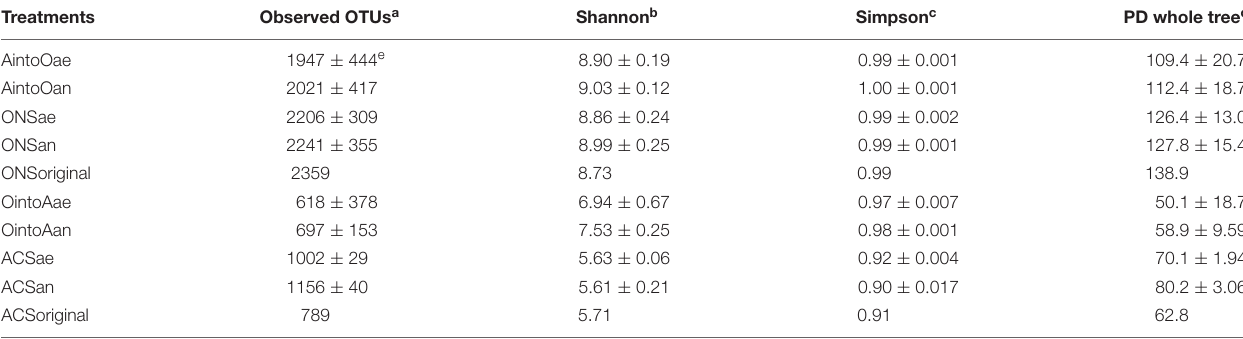
TABLE 3 | Alpha diversity indices of different